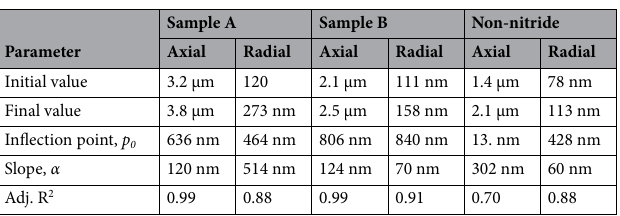
Table 3. Summary of sigmoidal fitting parameters for samples A, B, and